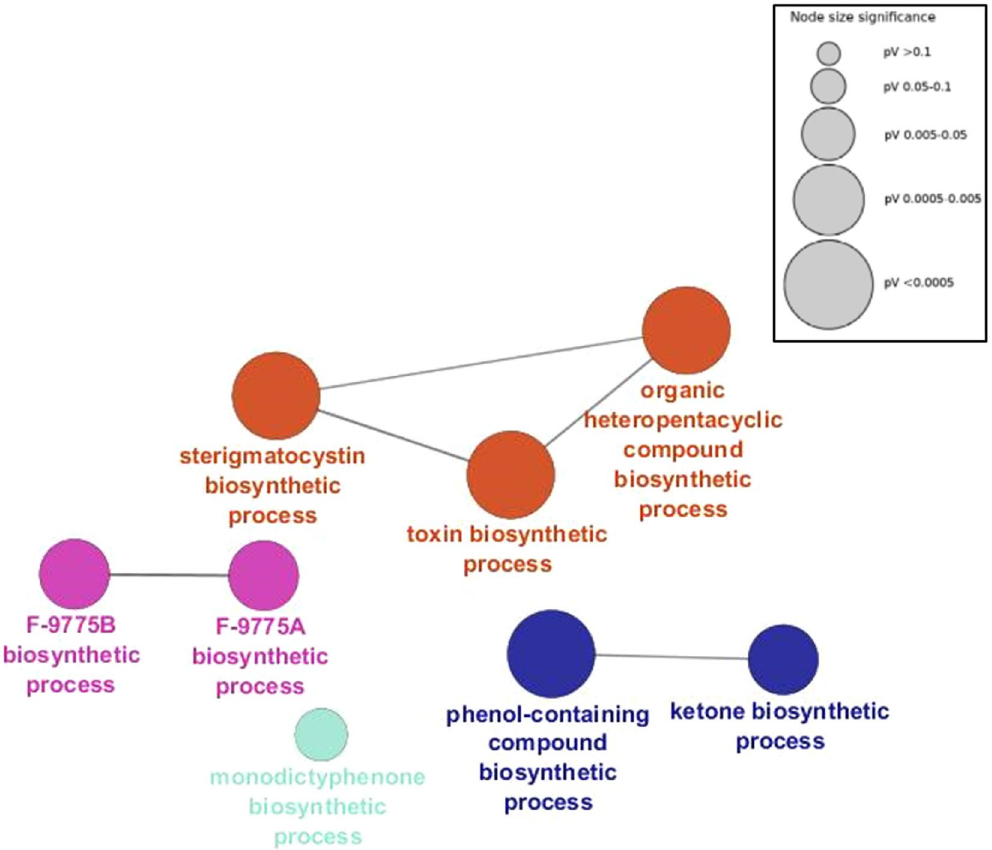
Figure 4. Gene Ontology Enrichment (GOE) analysis of the genes upregulated in celA Δ . Gene Ontology (GO) terms sharing similar associated genes are connected with a line. The circle sizes represent different p -values (inset).